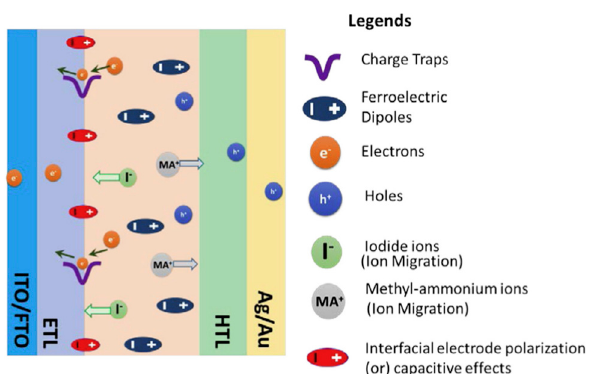
Figure 3. Schematic diagram shows the various ion/defects movements in perovskite device structure that could possibly lead to hysteresis phenomenon during current ‐ voltage characteristic measurements. The exact nature of each ion ‐ movement processes and its degree of influence on hysteresis varies with respect to the device structure and materials involved. Reprinted with permission from [71]. 2018 Solar Energy Materials and Solar Cells.